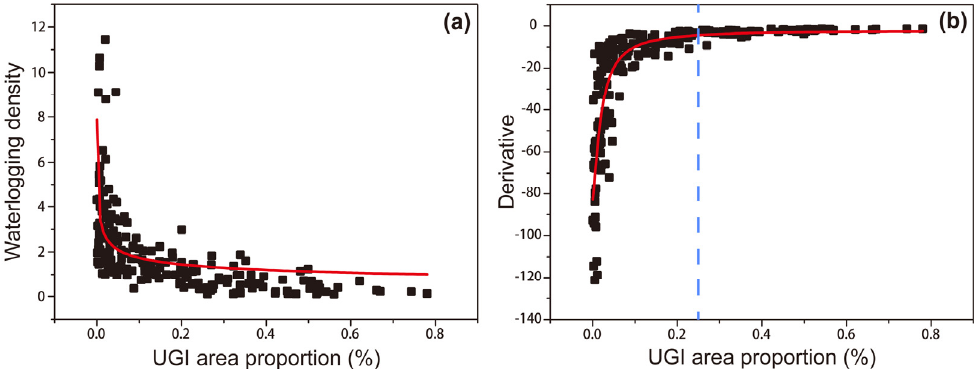
Figure 7. The logarithmic fitting ( a ) and the derivative ( b ) between UGI area proportion and waterlogging. The red line indicates the nonlinear fitting curve and the derivative curve, and the blue dashed line represents the threshold value.